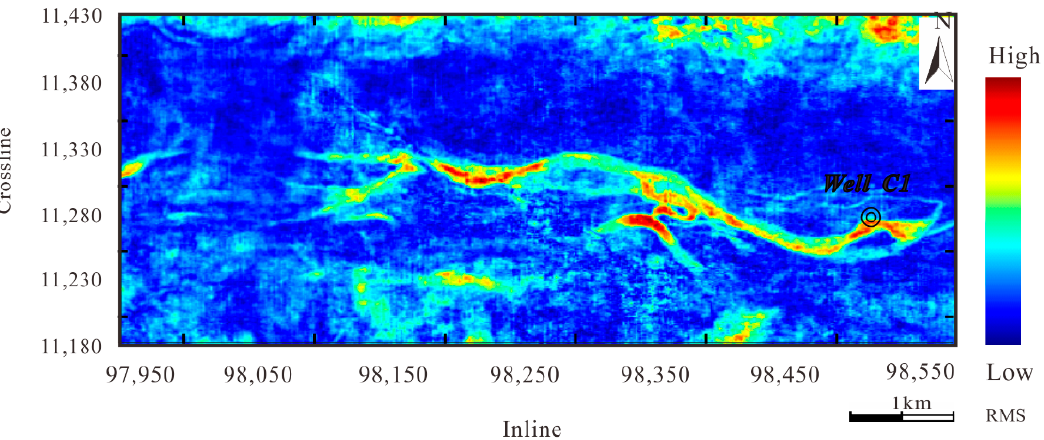
Figure 6. The RMS amplitude slices at t = 1650 ms calculated by full bandwidth seismic dataset.